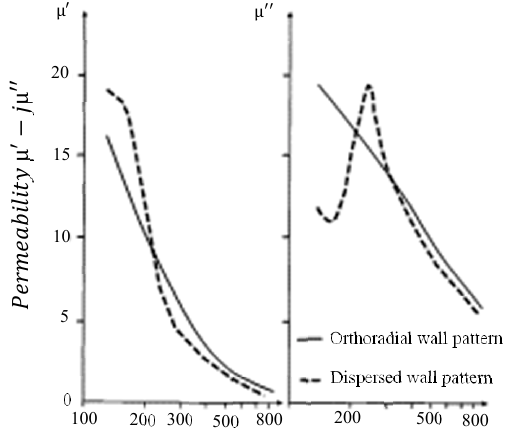
Figure 5. The permeability of a ferrite torus depends on whether it is non-defective or porous. The related wall pattern is orthoradial in the first case, and dispersed in the second case (figure adapted from [17]).